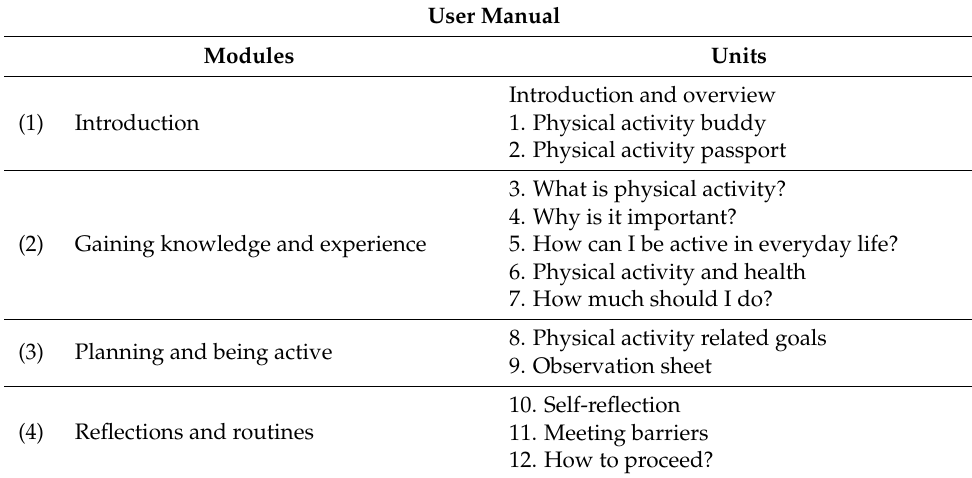
Table 4. Overview of modules and units within the user